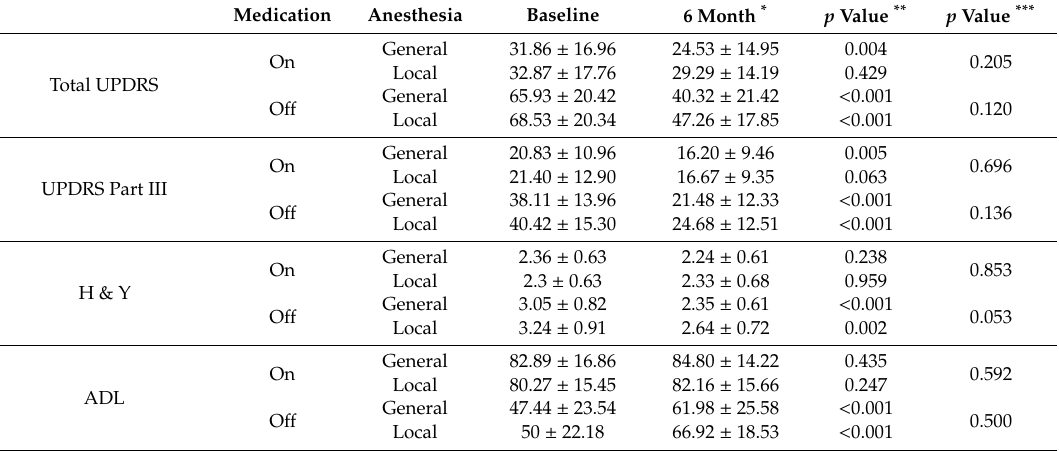
Table 6. Summary of clinical outcomes of bilateral subthalamic nucleus deep brain stimulation under local and general